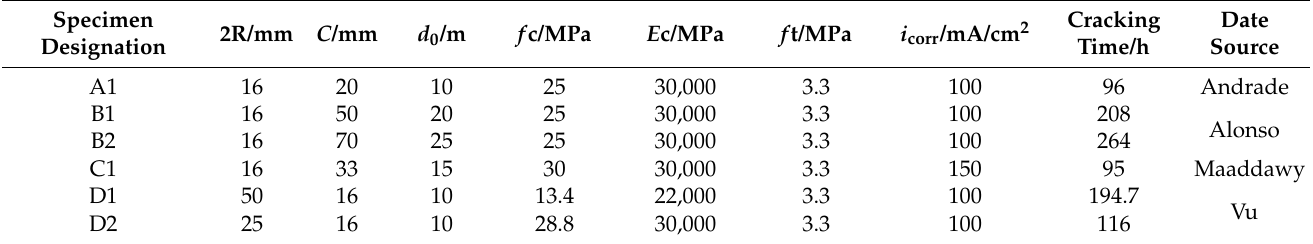
Table 3. The value of basic parameters. d 0 : thickness of porous zone; i corr : corrosion current densitiy.